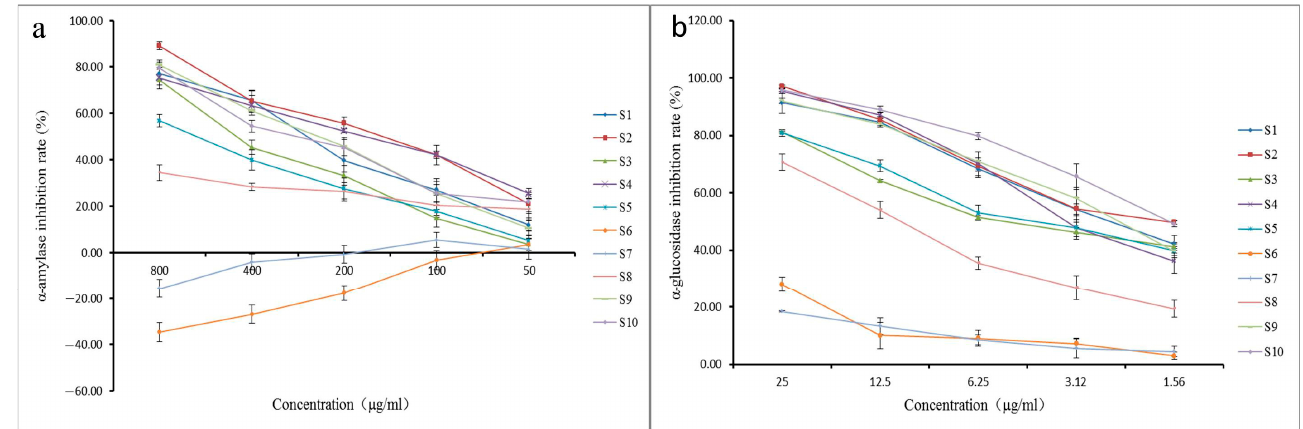
Figure 4. α -Amylase and α -glucosidase inhibition rates of different polarity extracts of A. clypearia . ( a ) Inhibition rate of α -amylase; ( b ) inhibition rate of α -glucosidase. ( a ) Inhibition rate of α -amylase; ( b ) inhibition rate of α